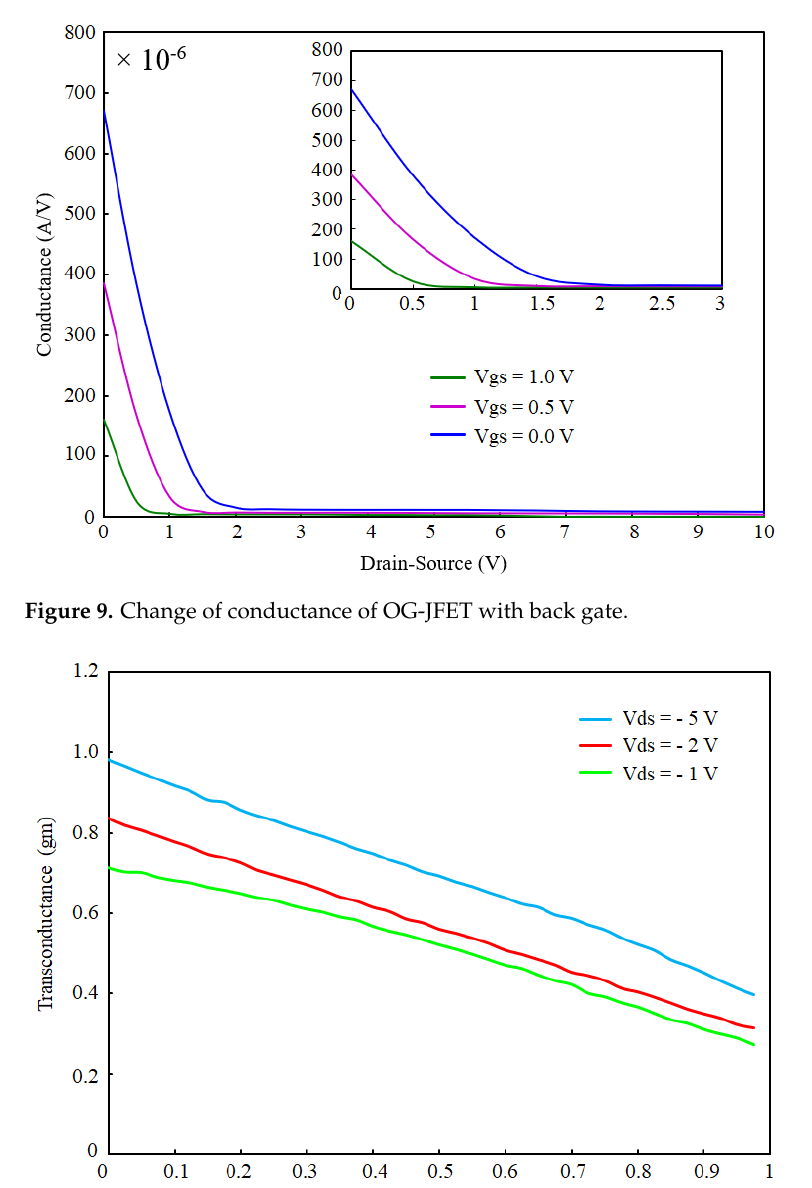
Figure 10. The transconductance of OG ‐ JFET calculated for different values of back ‐ gate